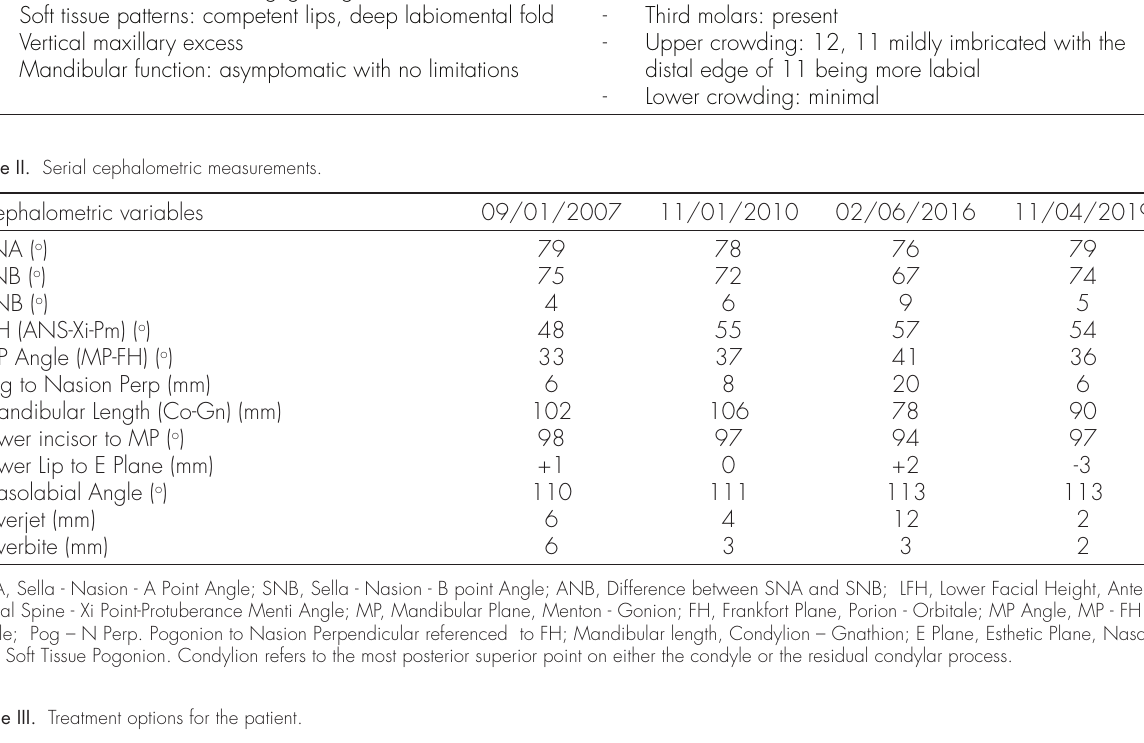
- Dentition: previous removal of four premolars as part of orthodontic treatment - Third molars: present - Upper crowding: 12, 11 mildly imbricated with the distal edge of 11 being more labial - Lower crowding: minimal